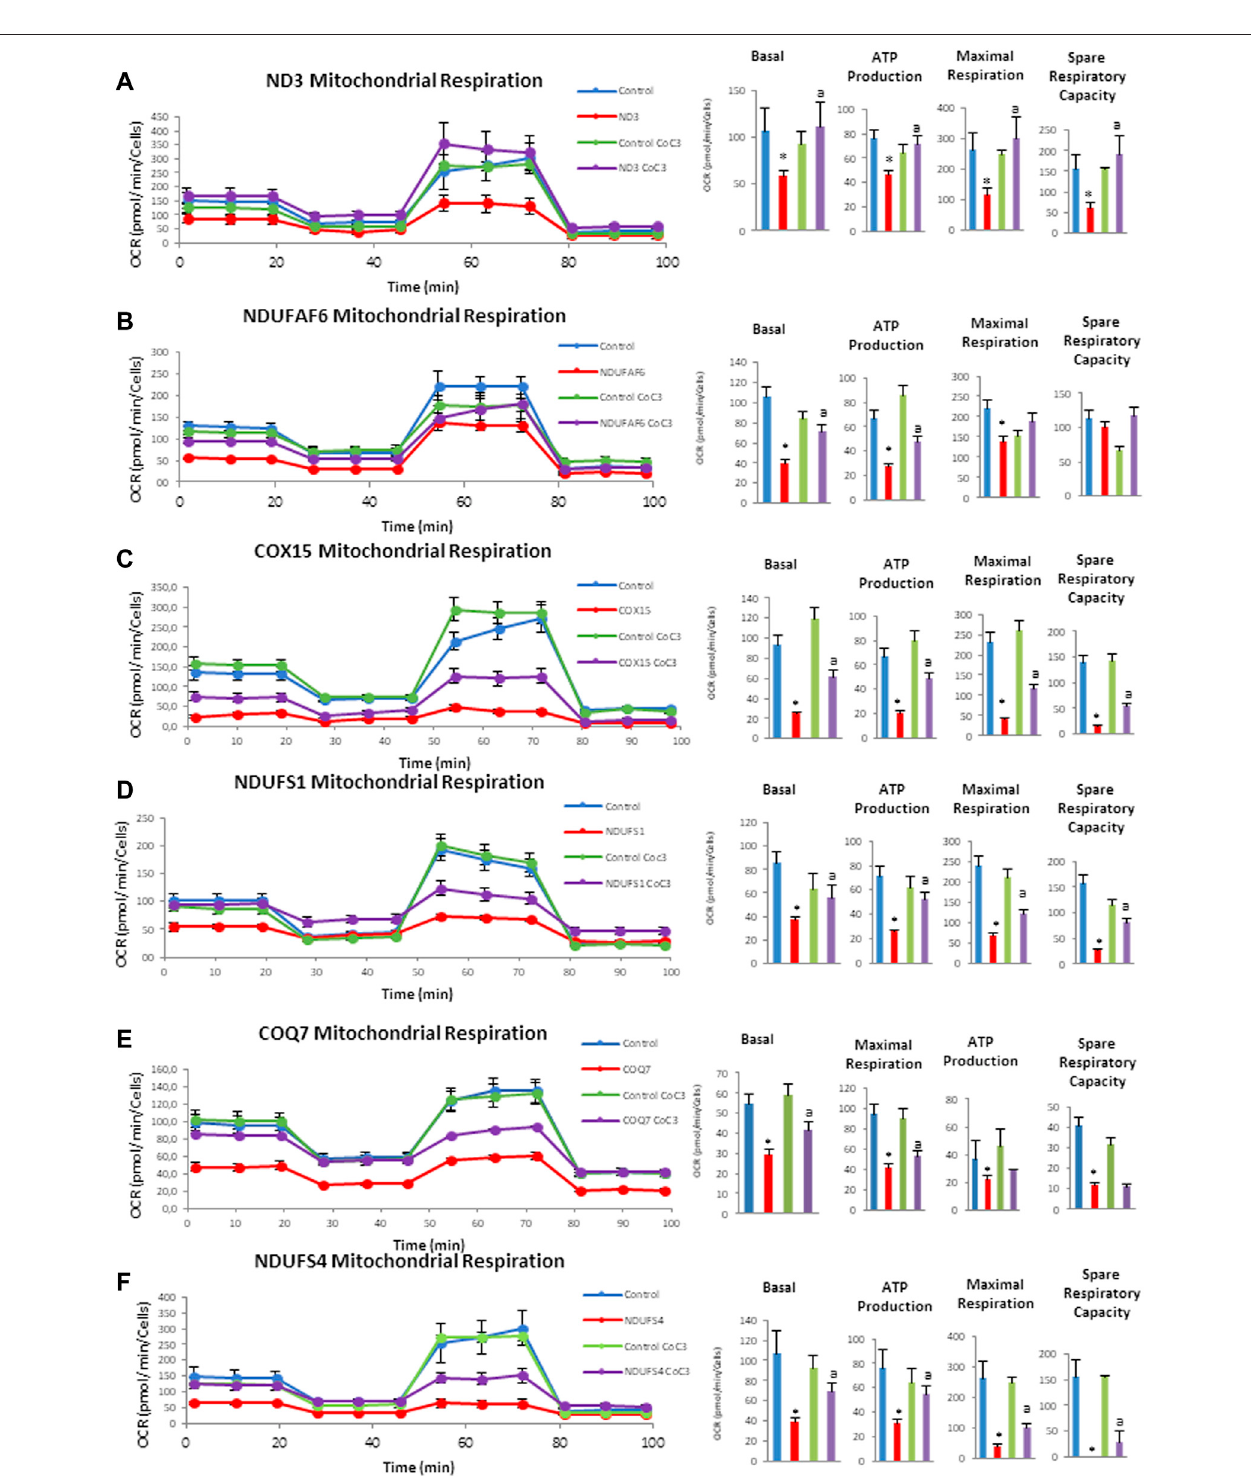
FIGURE 5 | Effect of CoC3 on mitostress bioenergetic assays in control and mitochondrial mutant cell lines. Mitochondrial respiration pro fi le was measured with a SeahorseXFe24analyzer.Fibroblastsweretreatedfor7days withCoC3 treatment: 1 μ MPterostilbene,5 μ Mnicotinamide,1 μ Mribo fl avin,1 μ Mthiamine, 1 μ Mbiotin, 5 μ M lipoic acid and 1 μ M L -carnitine. Mutations in fi gure panels: mtND3 (A) , NDUFAF6 (B) , COX15 (C) , NDUFS1 (D) , COQ7 (E) , NDUFS4 (F) . * = p < 0.01 between Control and mutant fi broblasts. a p < 0.01 between untreated and treated mutant fi broblasts. OCR, oxygen consumption rate.